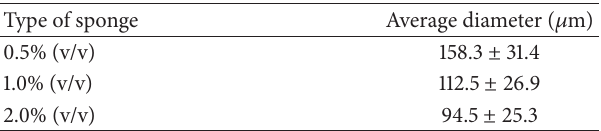
Table 2: The pore sizes of sponge with different concentrations of TAC. Type of sponge Average diameter ( 𝜇 m)